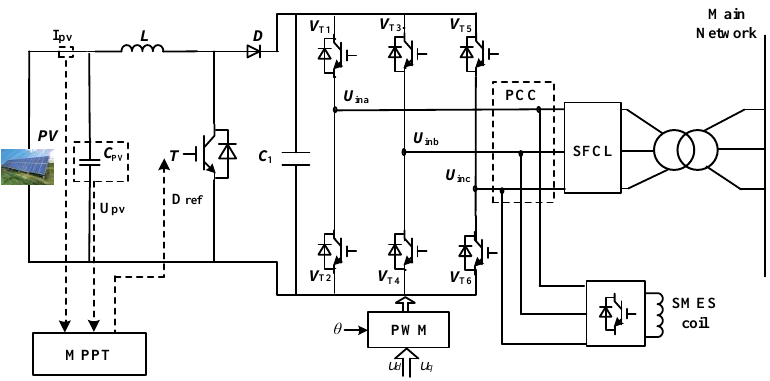
Figure 1. Configuration of a grid-connected photovoltaic (PV) generation system with superconducting fault current limiter (SFCL) and superconducting magnetic energy storage (SMES). PCC: point of common coupling; MPPT: maximum power point tracking; and PWM: pulse width modulation.